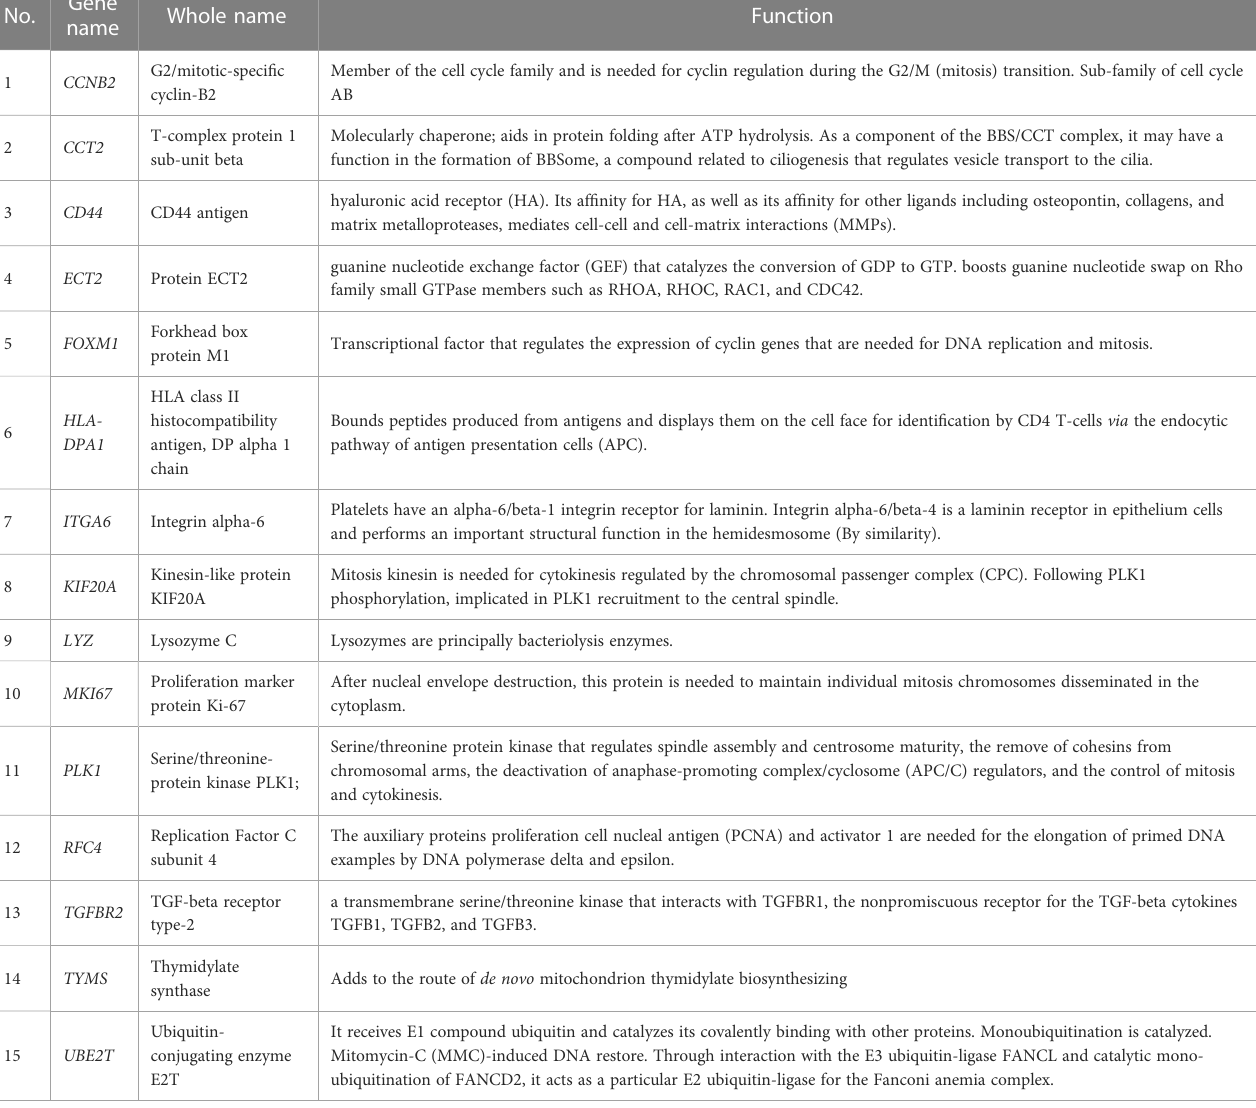
TABLE 2 Functional annotation of 15 hub genes selected by cytoHubba.